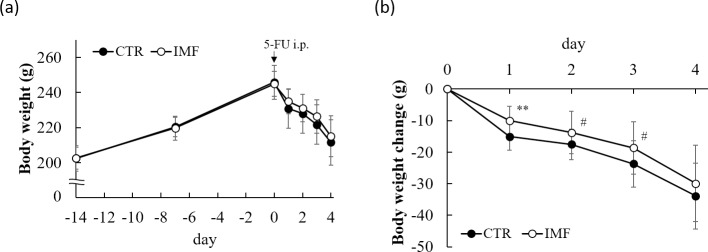
Body weight change over time in the CTR and IMF rats.(a) body weight and (b) body weight change from day 0. Values are means ± standard deviations. # P < 0.1, ** P < 0.01, vs. CTR group.